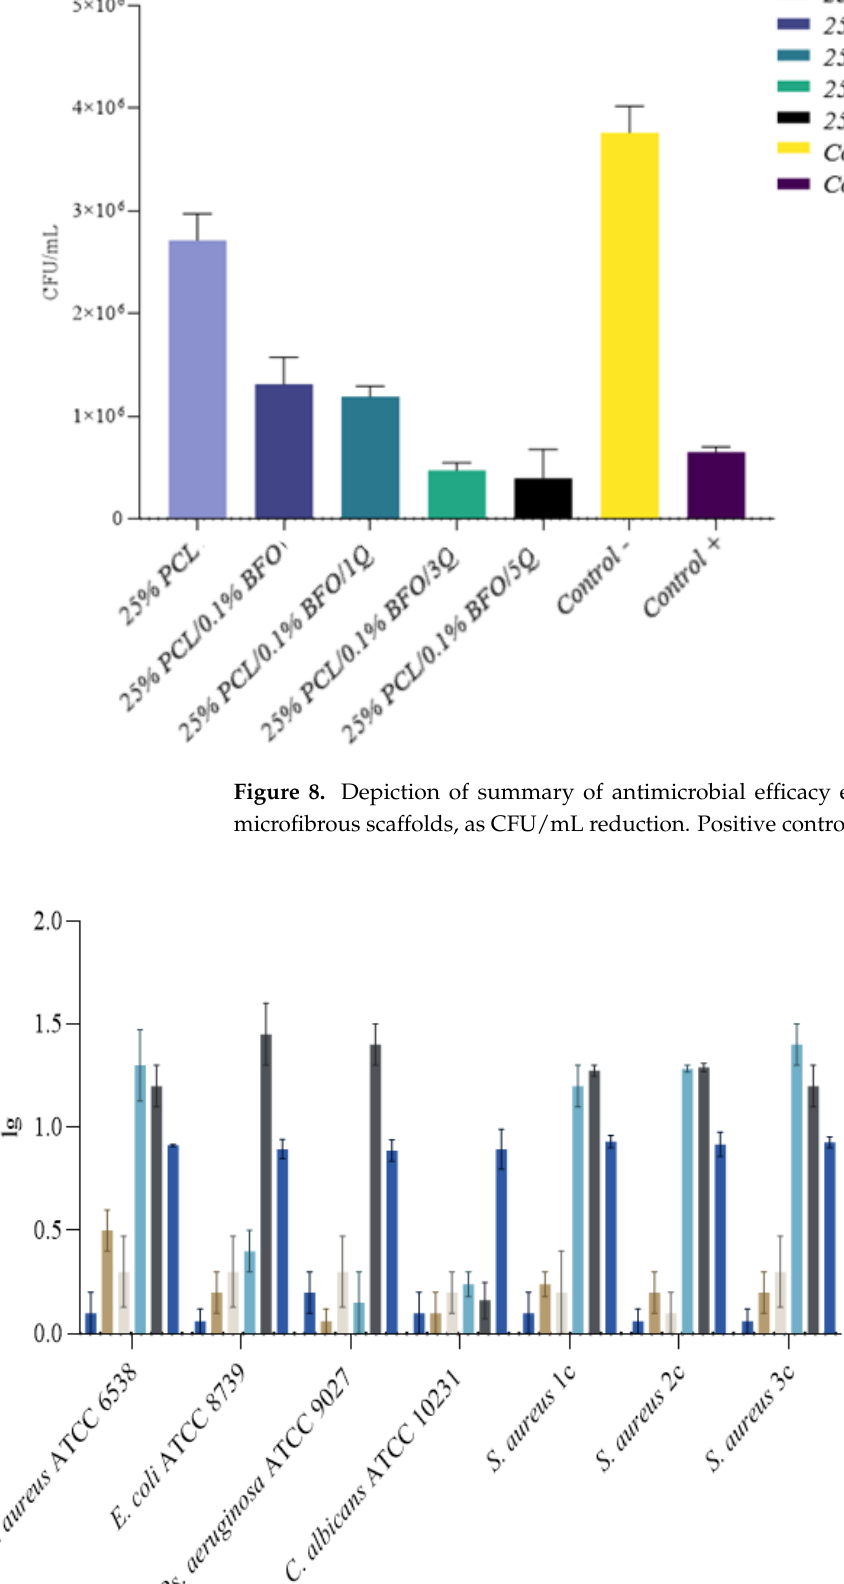
Figure 9. Antimicrobial efficacy expressed as lg for microfibrous scaffolds, as CFU/mL reduction. Positive control = 5 mg/mL Q solution.